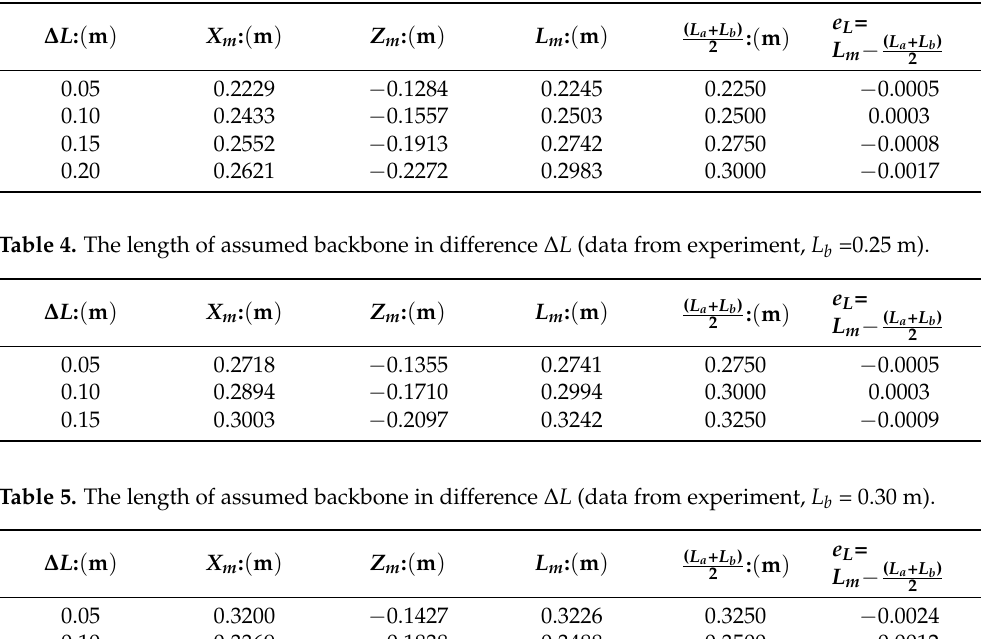
Table 3. The length of assumed backbone in difference ∆ L (data from experiment, L b = 0.20 m).